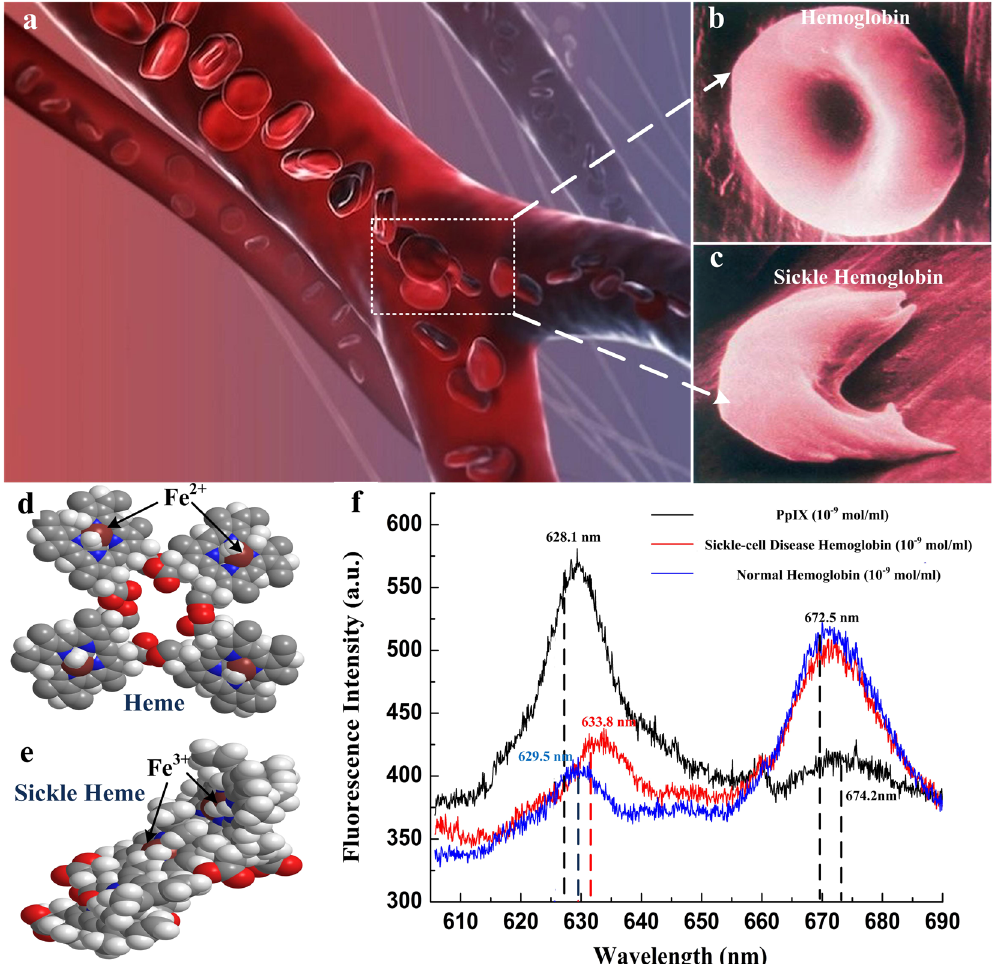
Figure 1. Hemoglobin from SCD patient and normal person. ( a ) SCD hemoglobin in vessels (drawn by 3ds Max 2013 soft ware); ( b ) and ( c ) Schematic diagrams of the normal Hemoglobin and SCD hemoglobin (drawn by 3ds Max 2013 soft ware); ( d ) and ( e ) Molecule models of the Heme and sickle heme (drawn by Chem 3D soft ware); ( f ) The fluorescent spectra of Protoporphyrin, Hemoglobin and Sickle